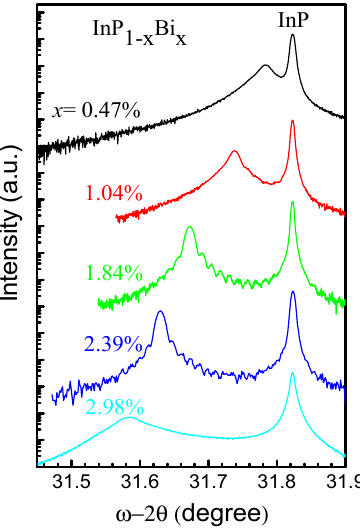
Figure 17. XRD of InPBi with different Bi contents.